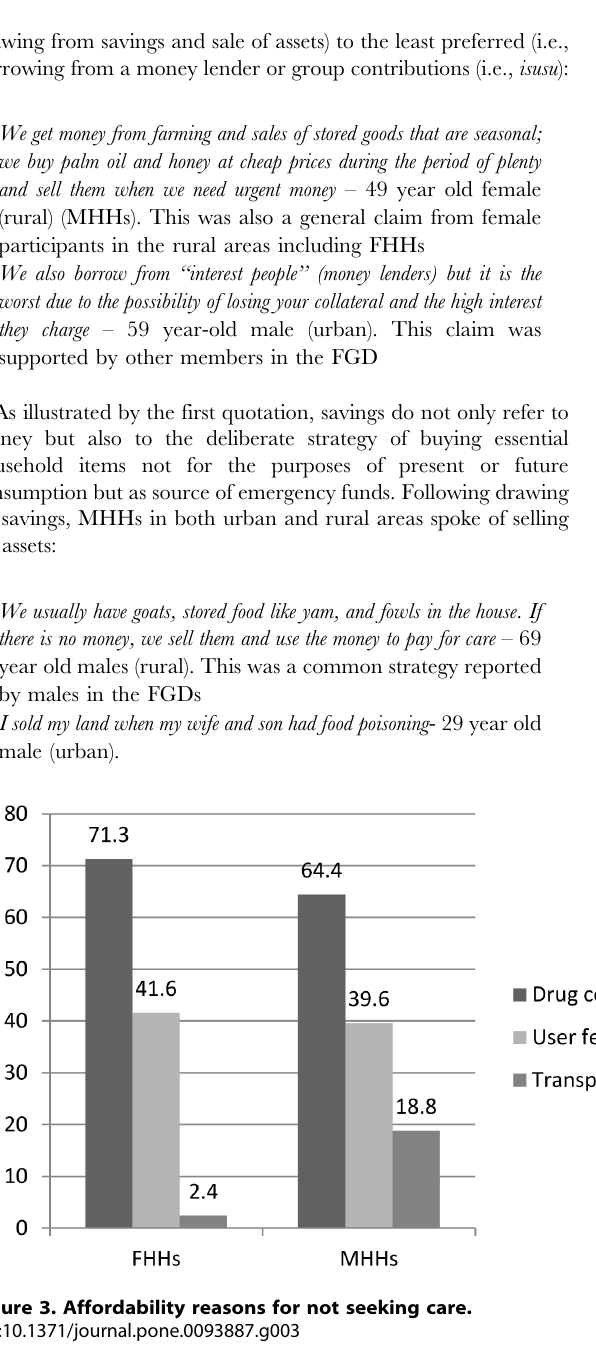
Socioeconomic group